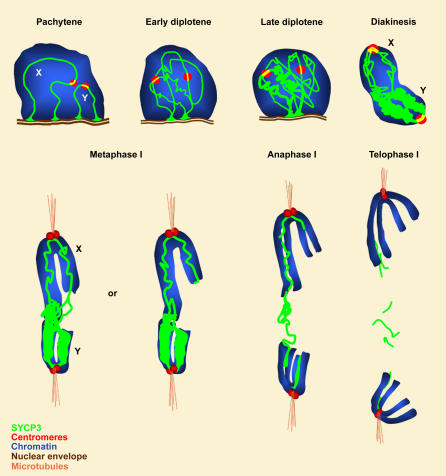
Schematic Representation of the Pairing and Segregation Dynamics of the Sex Chromosomes in M. unguiculatus Male MeiosisThe AEs of the sex chromosomes appear physically separated at pachytene, but closely related at the periphery of the nucleus. As the chromosomes increase their condensation at early diplotene, the AEs tend to fold and their tips establish an end-to-end contact. At the end of diplotene, SYCP3 reorganizes on the AEs, and acquires a diffuse pattern, mainly on the Y chromosome. At diakinesis sex chromosomes are end-to-end connected, in a conformation that is maintained up to metaphase I, and SYCP3 appears covering the Y chromosome and the distal region of the X chromosome. Our proposal is that the physical connection mediated by SYCP3 at this stage is responsible for maintaining sex chromosome association. Once sex chromosomes have achieved a bipolar orientation on the metaphase I spindle they tend to move to opposite poles. At this point the SYCP3-mediated association may break at the short arm of the X chromosome. At anaphase I chromosomes move to opposite poles. However, an SYCP3 filament remains associating both sex chromosomes, probably causing the delay of sex chromosome migration at anaphase I. This filament ultimately detaches from sex chromosomes during telophase I.